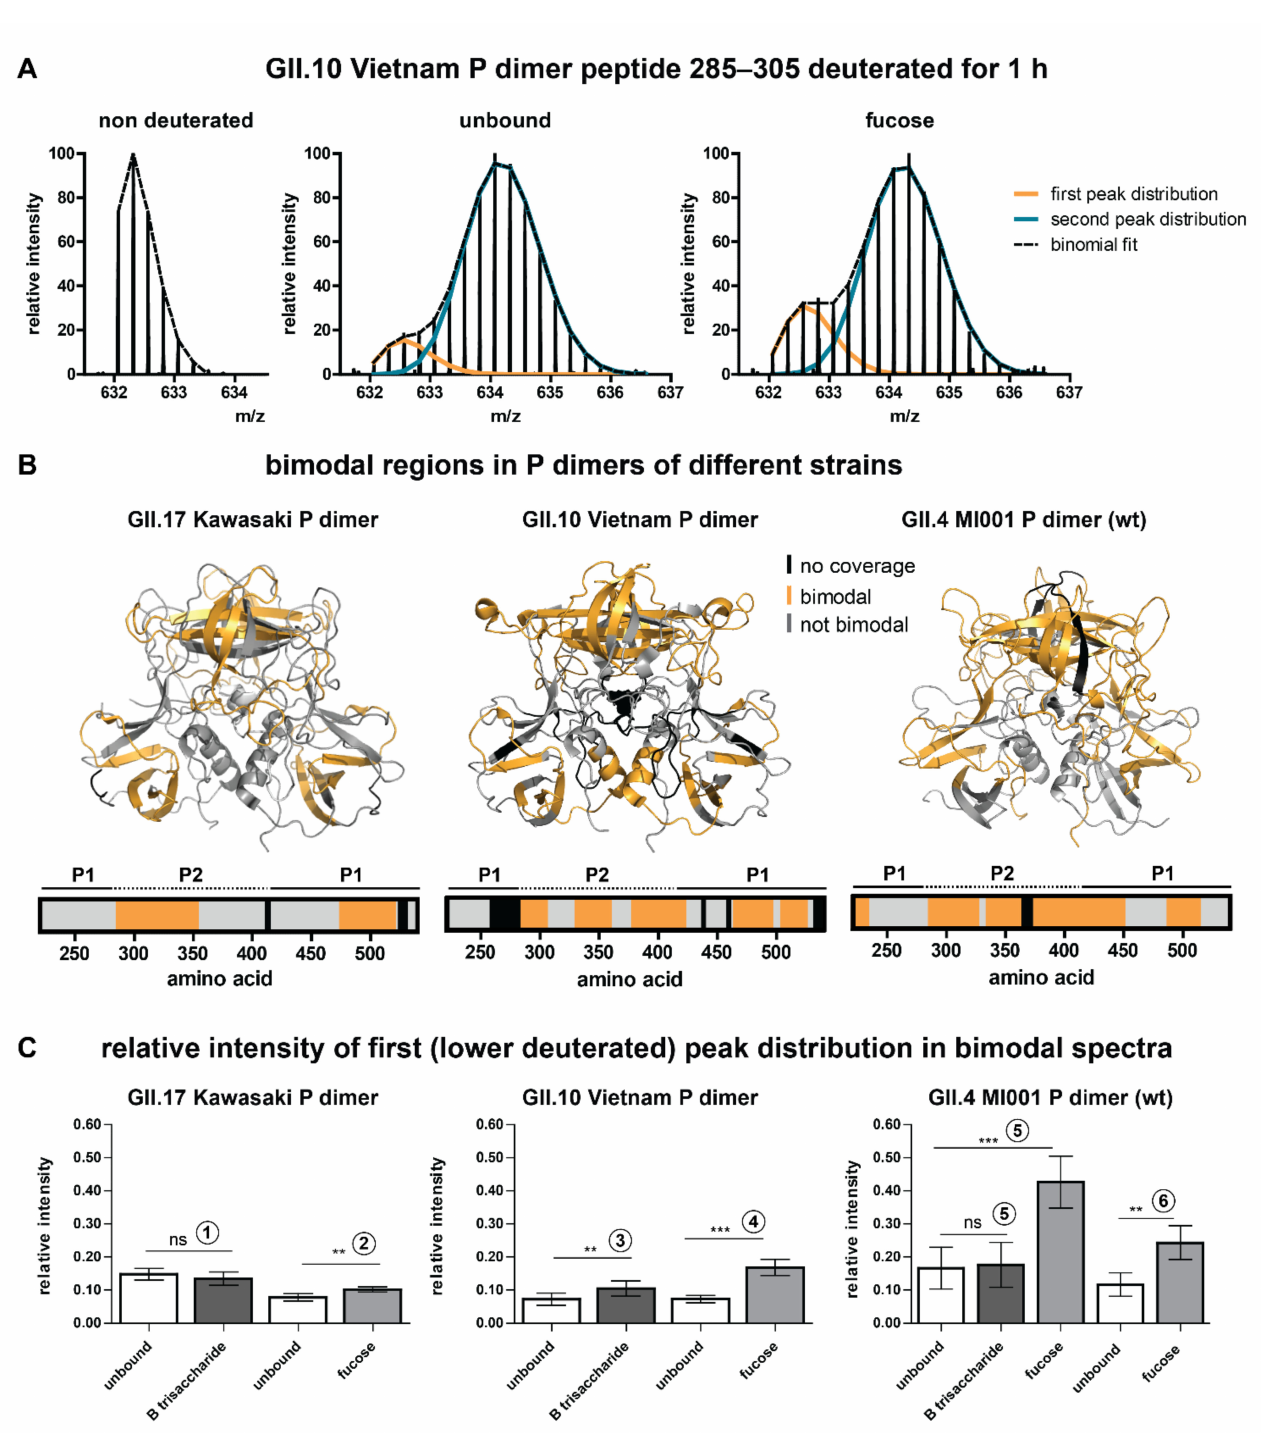
Figure 2. Bimodal peak distributions in some peptides point towards the existence of a second, more compact subpopulation. ( A ) Bimodality in deuterated spectra of an exemplary peptide of the GII.10 Vietnam P dimer. Bimodality occurs in both the unbound and the glycan bound state. Single peak distributions can be separated by binomial fitting. ( B ) Regions in P dimers of different strains that show bimodality in deuterated spectra (orange). Bimodality mainly occurs in the P2 domain and the lower part of the P1 domain in all strains. The amino acid numbering is based on the VP1 sequence. ( C ) Relative intensity of the first (lower deuterated) peak distribution for different strains and individual experiments (1–6) calculated